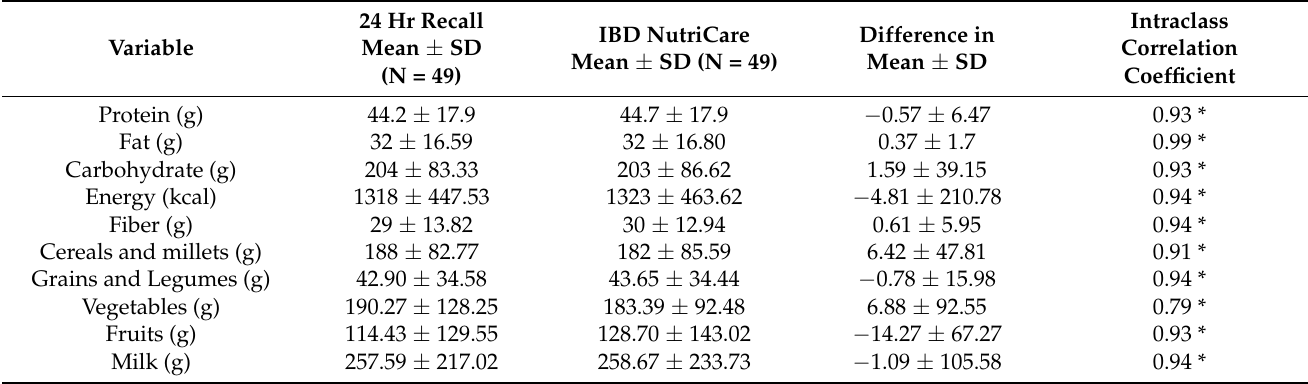
Table 2. Comparison between 24-h recall vs. IBD NutriCare app (Mean and standard deviation with 95% CI and Interclass correlation coefficient).